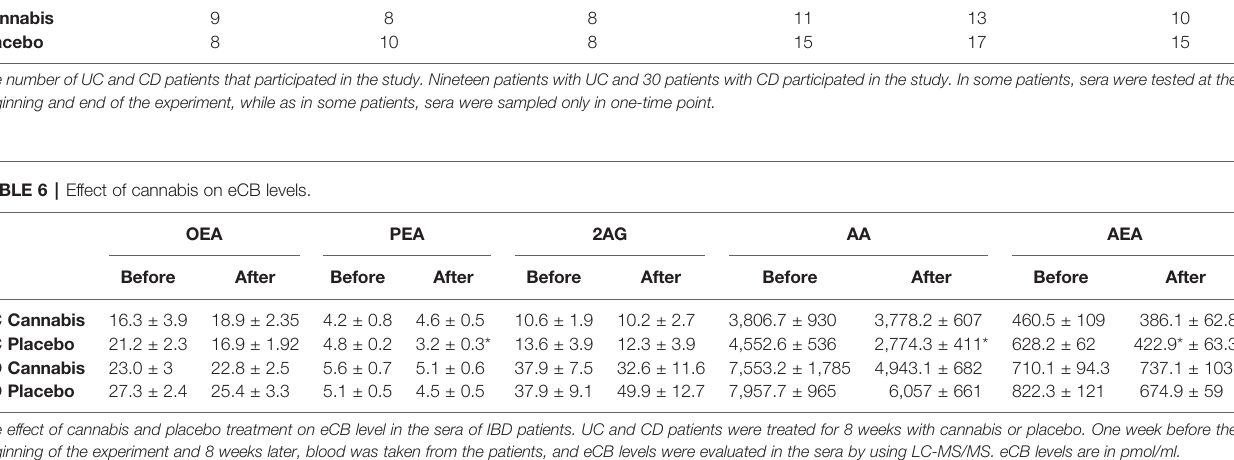
TABLE 5 | Number of UC and CD patients. Treatment UC CD Before After Paired results Before After Paired results